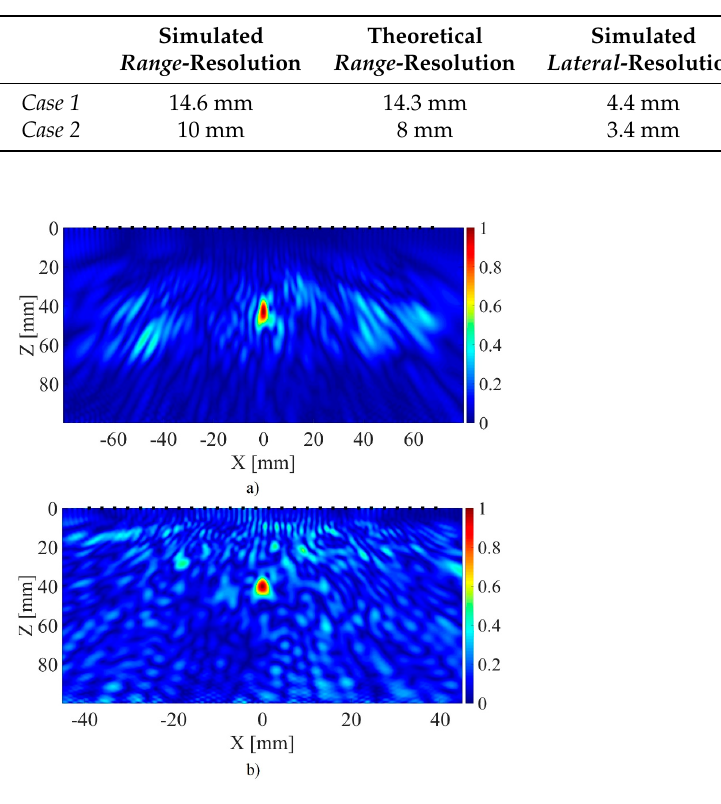
Figure 5. Simulated Point Spread Function for ( a ) Case 1 and ( b ) Case 2 .